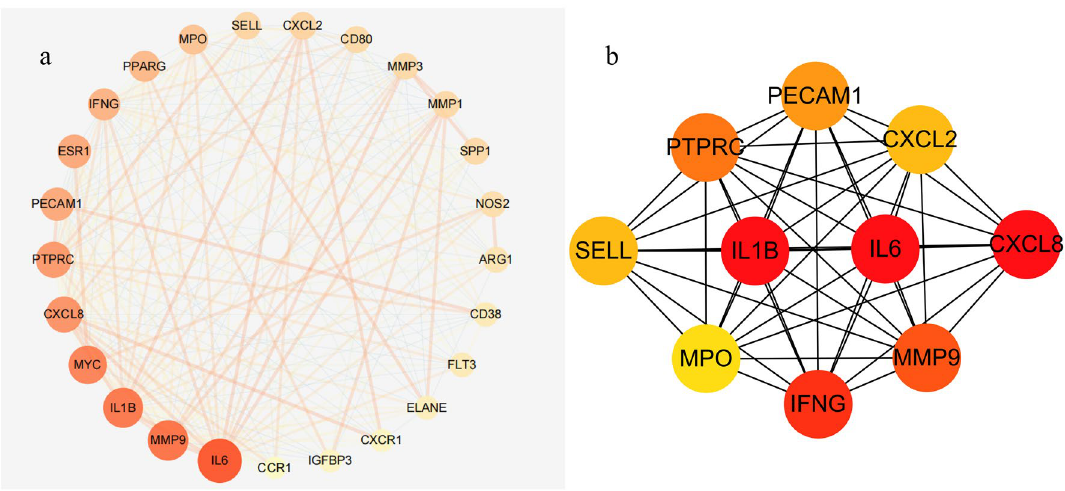
Figure 7. Protein–protein interaction network. ( a ) PPI network of target genes using MCODEm ( b ) subnetwork of top nine hub using CytoHubba. Node color reflects the degree of connectivity (red color represents a higher degree, and yellow color represents a lower